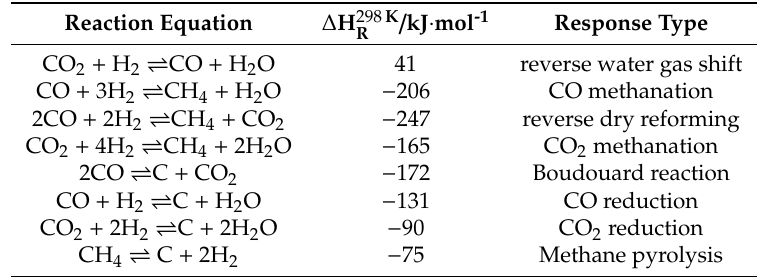
Table 4. Main reactions and side reactions that occur during CO 2